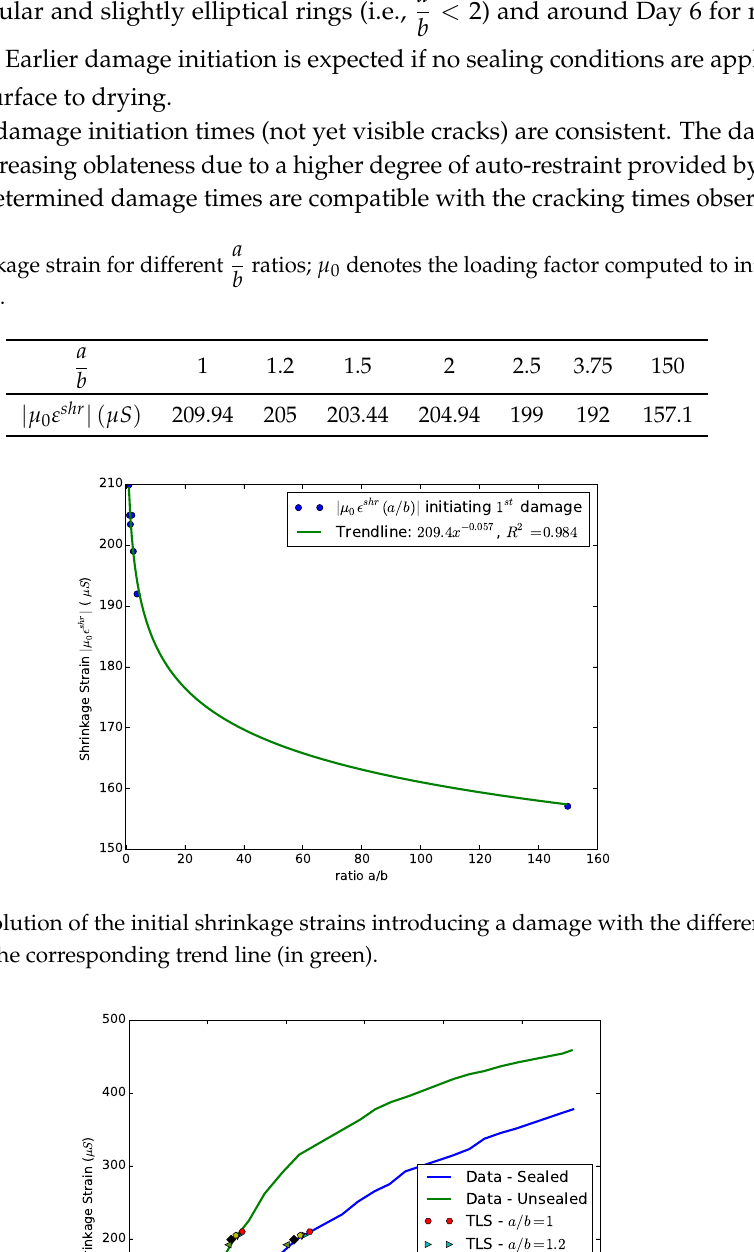
a ratios; µ 0 denotes the loading factor computed to introduce an b